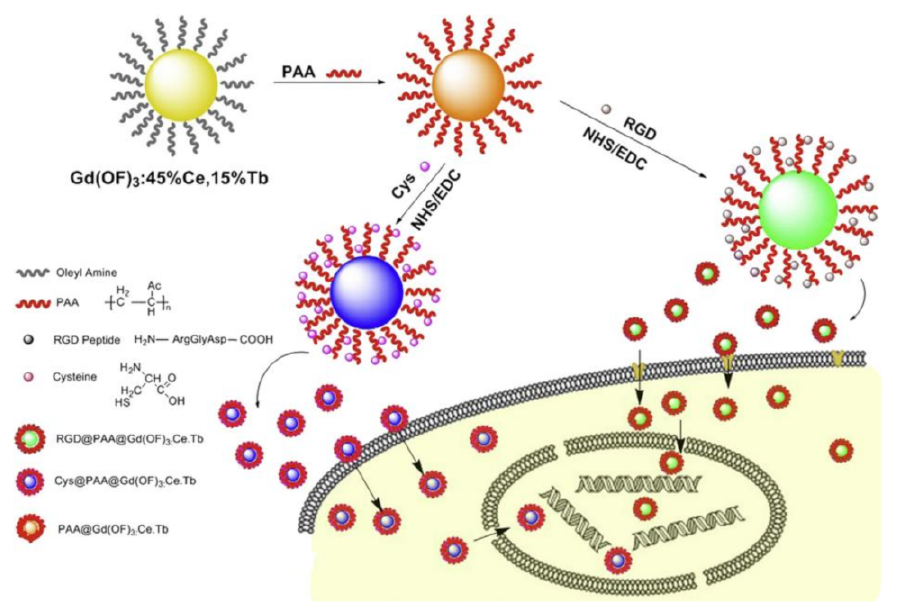
Figure 6. Schematic illustration for the synthesis of RGD and Cys functionalized Gd(OF) 3 : Ce, Tb nanocrystals and their targeted imaging. The oleylamine capped nanocrystals were modified by polyacrylic acid (PAA) to form the PAA capped Gd(OF) 3 : 45%Ce, 15%Tb nanocrystals (PAA@ Gd(OF) 3 : 45%Ce, 15%Tb) through a ligand exchange method. RGD peptide and cysteine were conjugated to the nanocrystals surface by EDC/NHS chemistry (Adapted from Yan et al. 2015 [154], Copyright 2015 Elsevier Ltd. and reproduced with